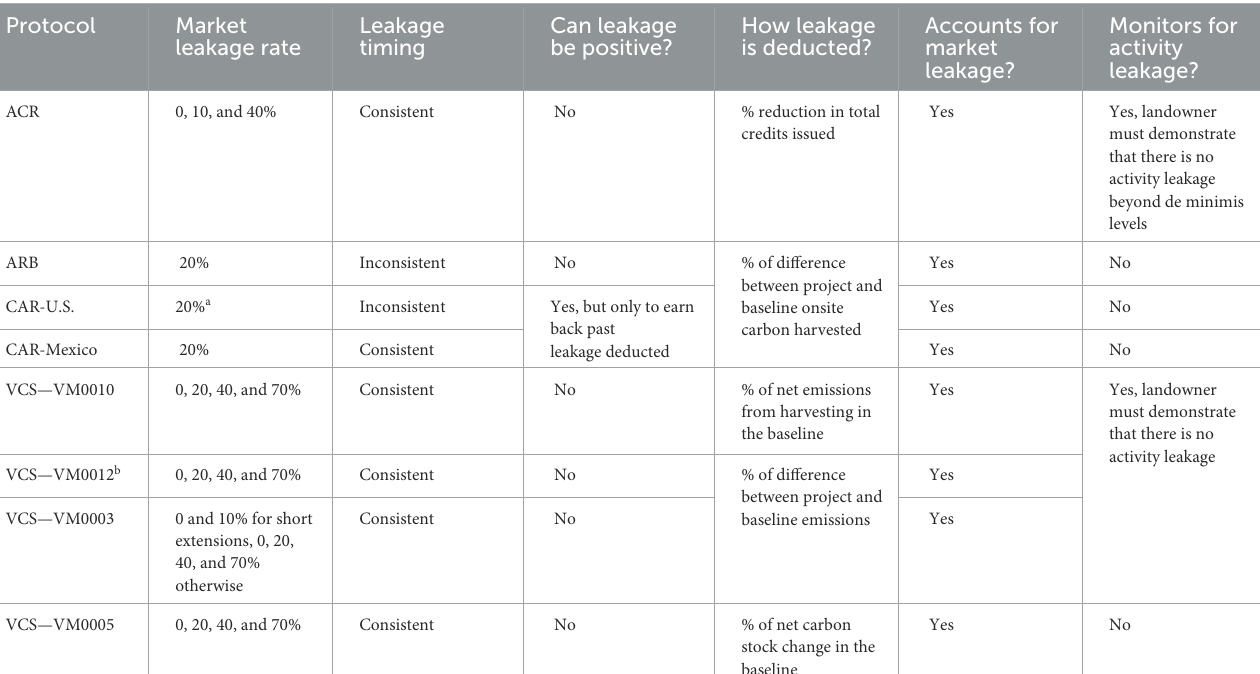
TABLE 3 Summary of leakage treatment in IFM